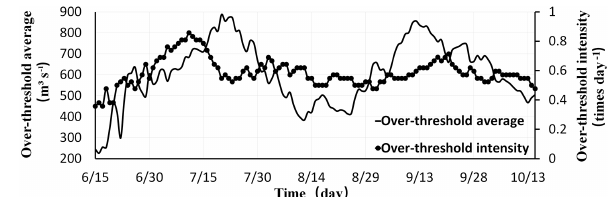
Figure 1. The change process of time-dependent parameters in de- sign frequency of